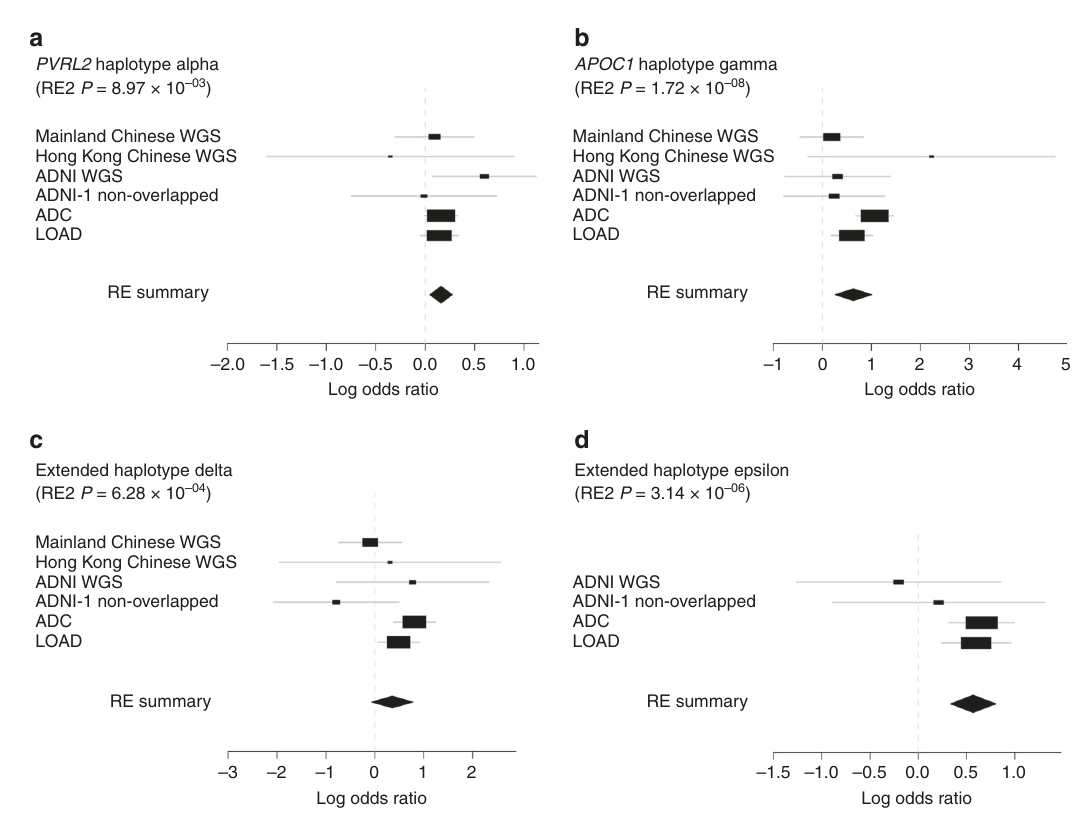
Fig. 3 Forest plot of haplotypes contributing to AD after controlling for APOE genotypes. Forest plot with values of effect size obtained from independent datasets or meta-results denoted by rectangles and diamonds, respectively. For each row representing the independent dataset, lines indicate 95% con fi dence intervals, and sizes of rectangles are proportional to the weights in the meta-analysis. a , b PVRL2 alpha and APOC1 gamma haplotypes were associated with AD in an APOE genotype-independent manner ( p -values shown are for Han and Eskin ’ s random effects model). c , d Association results of extended minor haplotypes delta and epsilon after controlling for APOE - ε 4 genotypes ( p -values are for Han and Eskin ’ s random effects model).